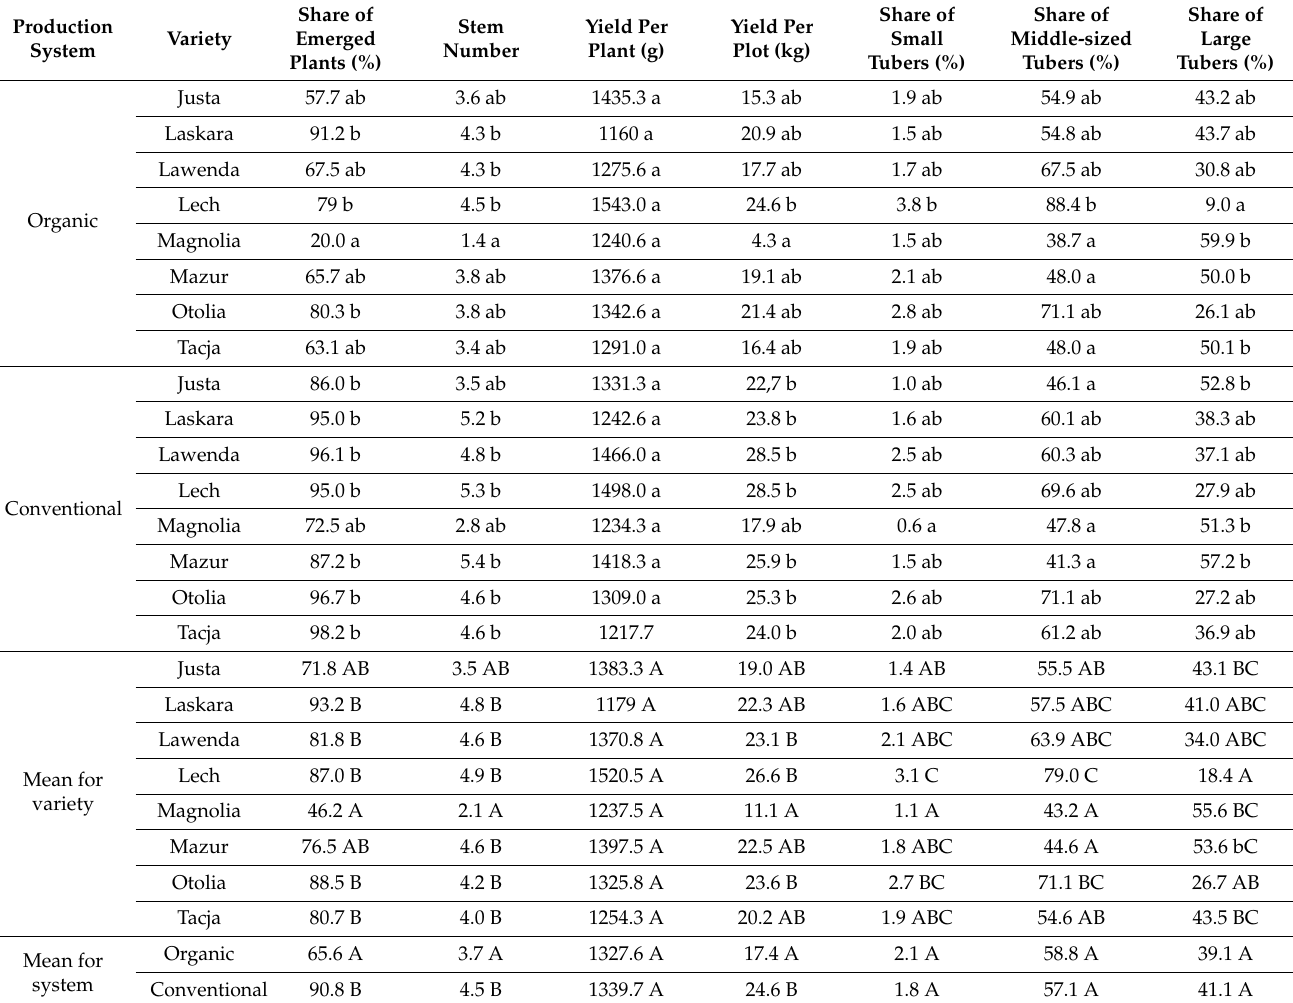
Table 7. The value of parameters characterizing tuber features in relation to variety and production system.